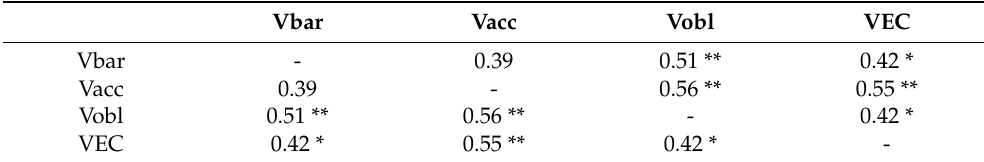
Table 4. Spearman’s correlations ( r s and significance). Vbar Vacc Vobl